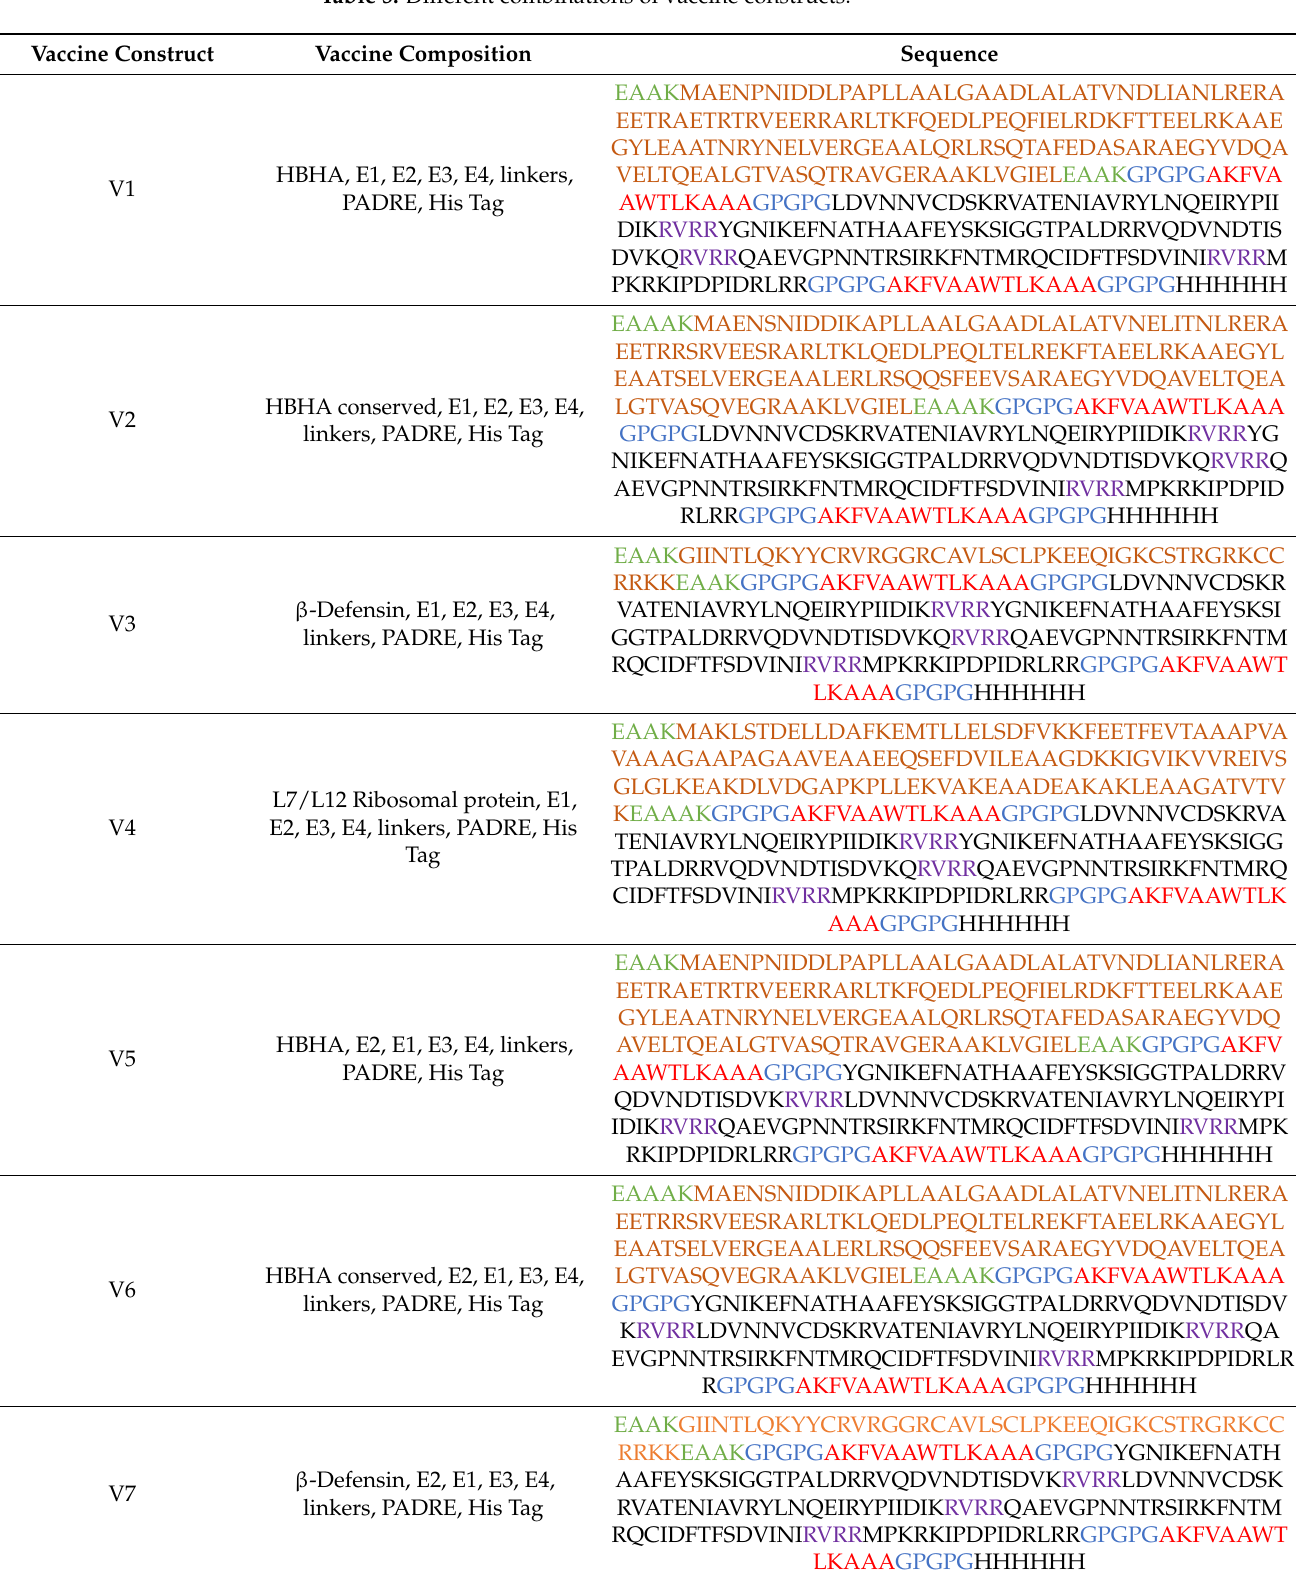
Table 5. Different combinations of vaccine